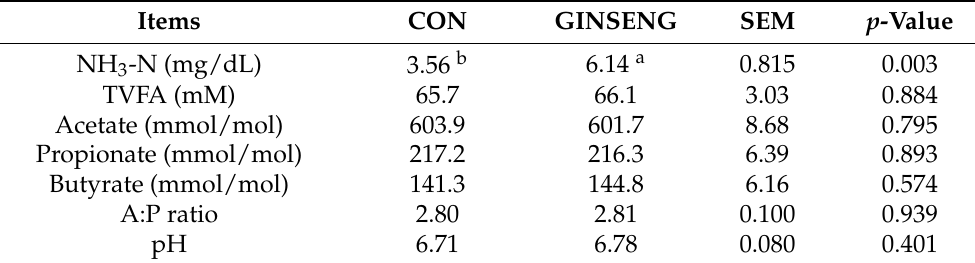
Table 6. Rumen fermentation characteristics of heat-stressed Hanwoo steers supplemented with red ginseng byproduct.